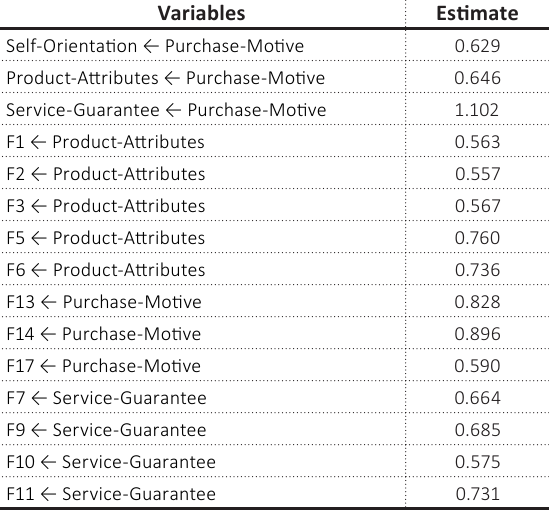
Table 6. Loading factor analysis